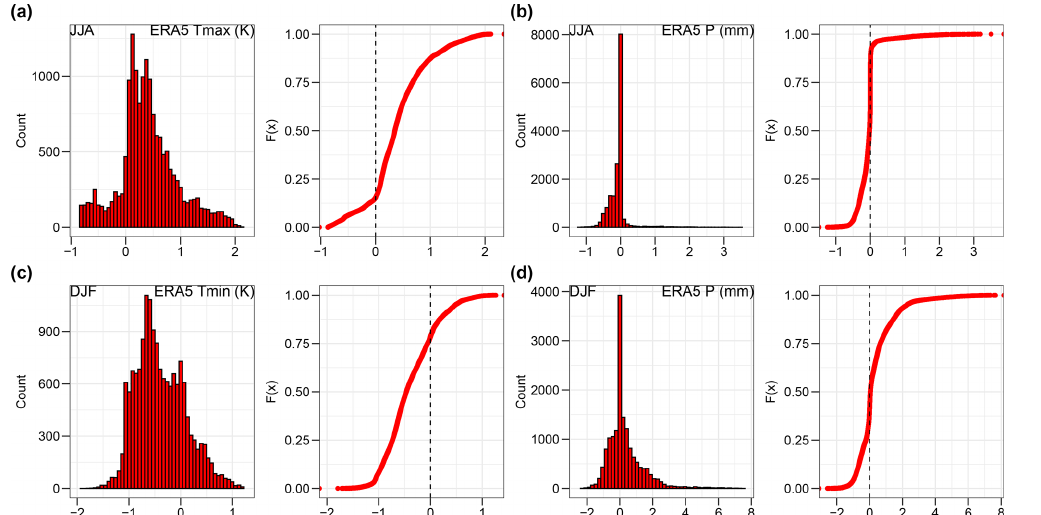
Figure 5. Histograms and cumulative distribution functions (CDFs) of anomaly means of (a) T max and (b) P during JJA CDEs and (c) T min and (d) P during DJF CDEs. The data are the same as in Fig. 4c–f. The distributions are statistically different from those of all other JJA and